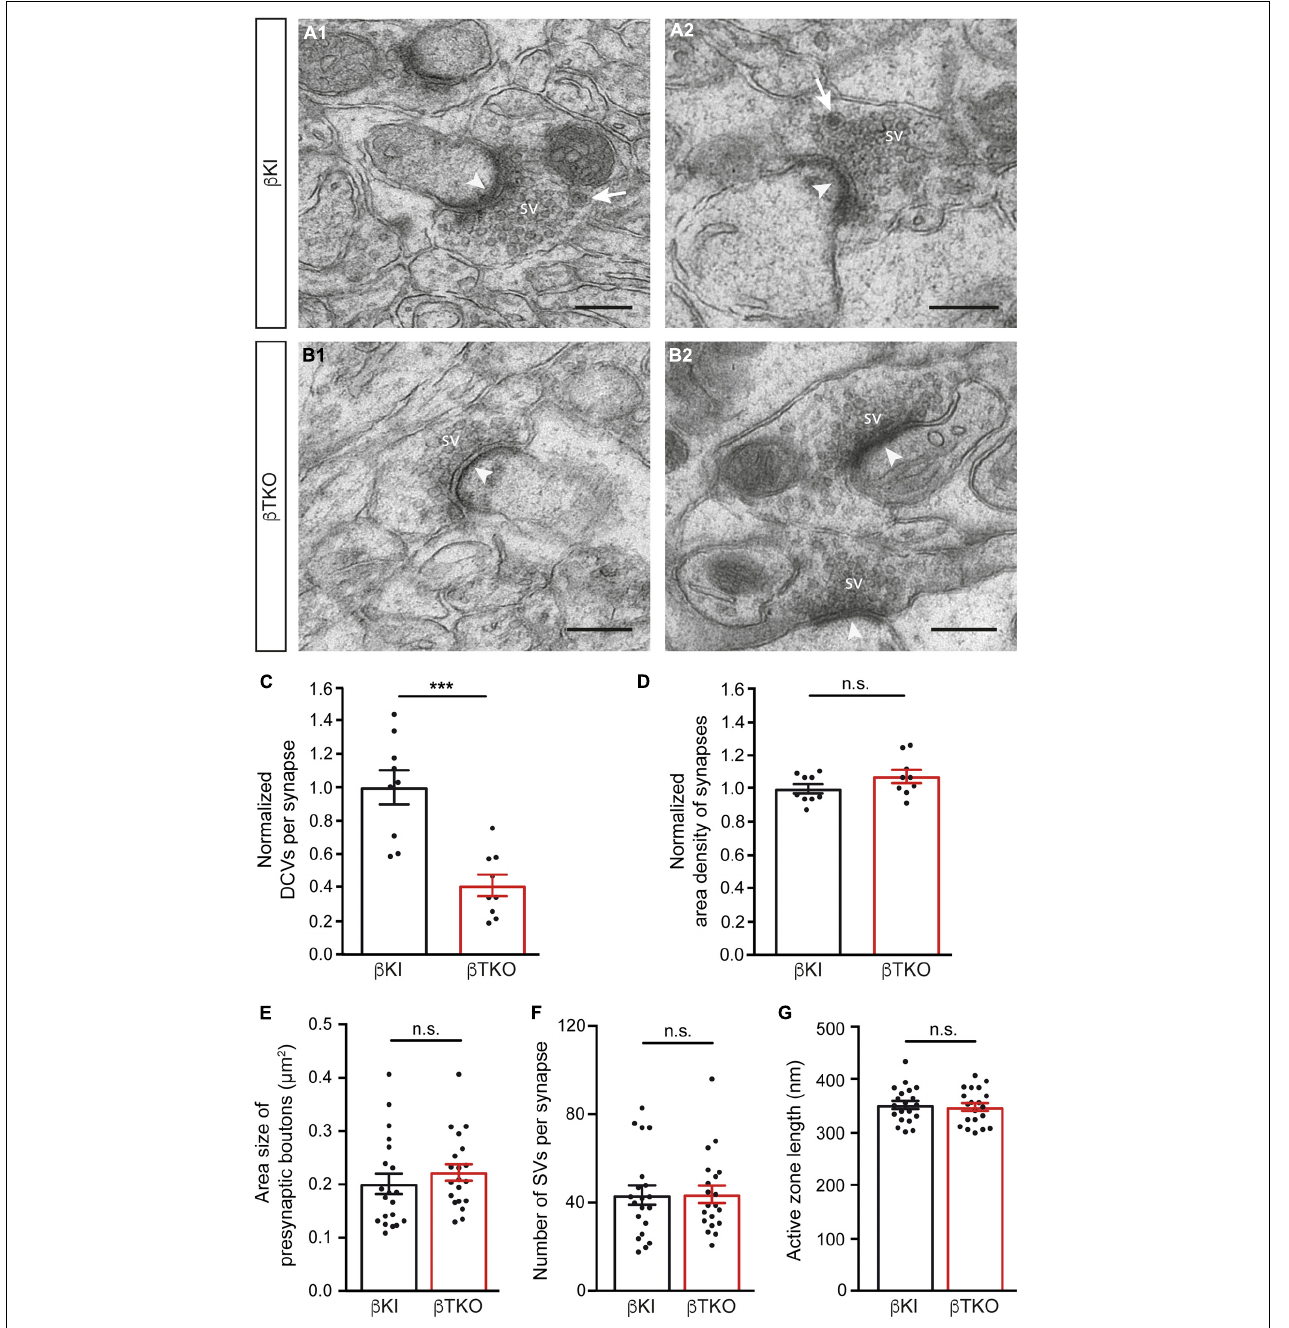
FIGURE 5 | Reduced DCV numbers in cerebellar parallel fiber terminals of β -Nrxn-deficient mice. (A1,A2) Representative electron microscopic images of type 1 synapses in the cerebellar molecular layer of β -KI control mice, likely corresponding to excitatory parallel fiber terminals of granule cells. Arrows point to DCVs at the periphery of synaptic vesicle clusters. SV = synaptic vesicle clusters; arrowheads, postsynaptic densities. (B1,B2) Similar images as in panel (A1,A2) from β -Nrxn-deficient β -TKO cerebellum. Scale bar, for panels (A,B) , 250 nm. (C,D) Histograms showing the number of DCVs (C) and the area density of type 1 excitatory synapses (D) in the molecular cell layer from β -KI control (black bars) and β -Nrxn-deficient β -TKO (red bars) cerebella. Data are normalized to control values and shown as mean ± SEM (for actual values, see section “Results”), dots indicate individual data points. Measurements are based on n = 9 cerebellar regions from three mice per genotype, corresponding to 3,123 µ m 2 of total area investigated; significance difference indicated as *** p = 0.0002 or n.s. = non-significant, two-tailed unpaired t -test. (E–G) Histogram summarizing the average area size (E) , average number of SVs (F) , and average length of the active zone (G) of presynaptic boutons from β -KI control (black bars) and β -Nrxn-deficient β -TKO (red bars) parallel fiber terminals. Samples as in panels (C,D) , data are shown as mean ± SEM; significance difference indicated as n.s. = non-significant, two-tailed unpaired t -test.